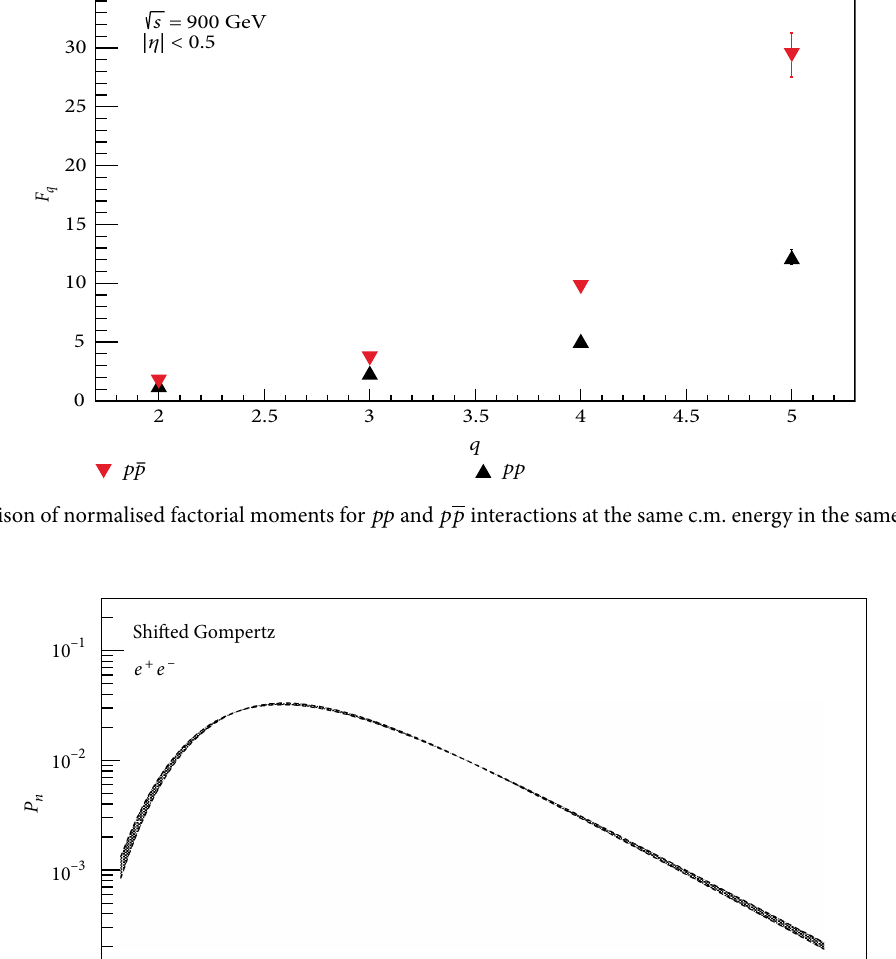
Figure 16: Probability distribution predicted from shifted Gompertz distribution, in 1 500